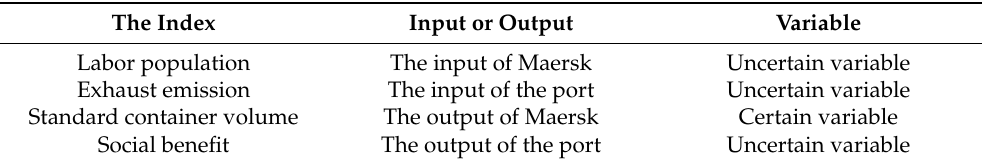
Table 1. The evaluation indexes of sustainable